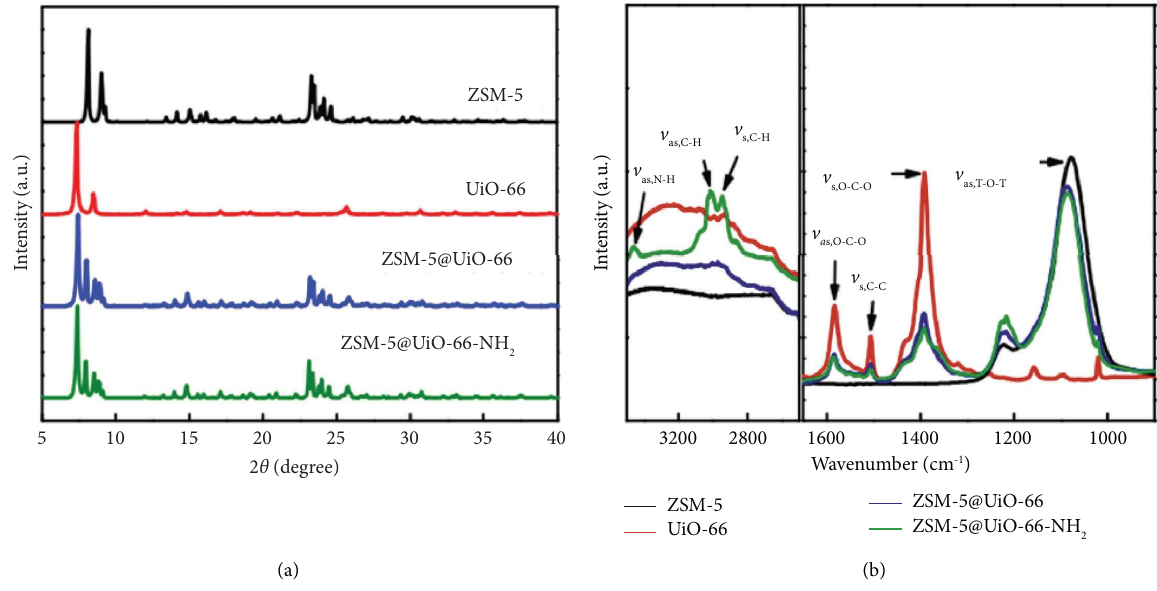
2 adopted from [25].